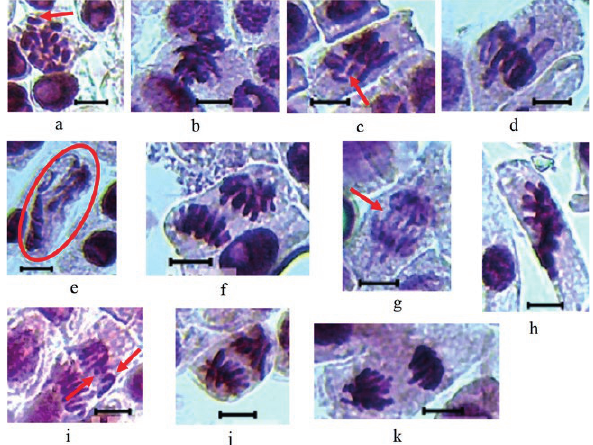
Figure 2. Types of chromosomal aberrations of A. cepa root tip cells after treatment with Ni, encapsulated E. acoroides leaves extract and combined Ni and encapsulated extract. a=prophase abnormality with fragments; b= sticky metaphase; c= fragment at metaphase; d=chain metaphase; e=vagrant telophase (circle); f=diagonal anaphase; g=chromosome bridge; h=diagonal meta- phase; i=fragment at anaphase; j=star anaphase; k=sticky anaphase. Scale bar=10μm. Arrows indicate